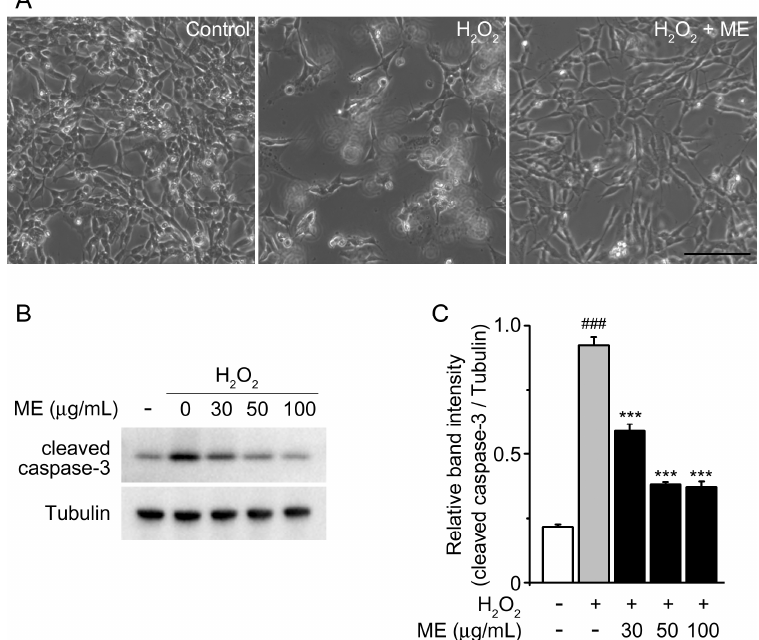
Figure 2. Effects of Melandrii Herba extract against H 2 O 2 -induced damage in cells. ( A ) Morphology of cells treated with H 2 O 2 in the absence or presence of Melandrii Herba extract (100 ug/mL) for 24 h. Representative morphology was determined by phase-contrast microscopy. Normal morphology of SH-SY5Ycells was present in the control. Scale bar = 100 µm; ( B ) Western blots of endogenous cleaved caspase-3 in SH-SY5Y cells treated with the indicated dose of Melandrii Herba extract in the presence of H 2 O 2 for 24 h. Tubulin was used as the loading control; ( C ) The ratio of cleaved caspase-3 to tubulin for the blot shown in ( B ). *** p < 0.005 , significantly different from the H 2 O 2 -treated control group. ### p < 0.005 , significantly different from the unstimulated control group.